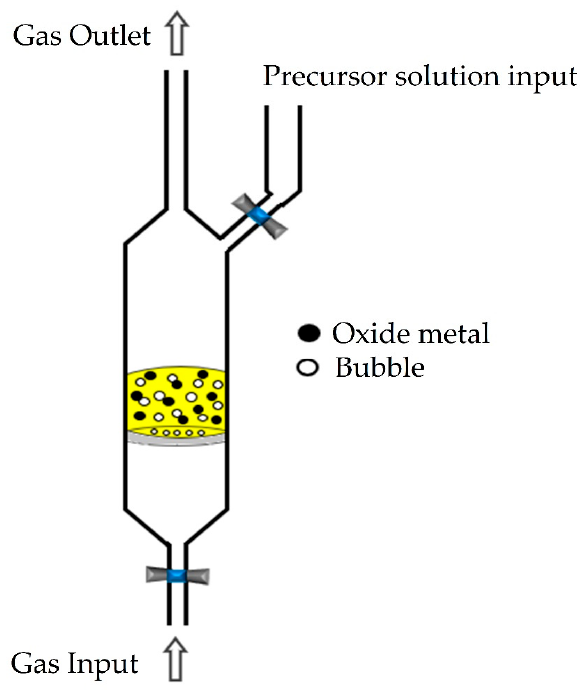
Figure 1. Diagram of the suspension reactor.